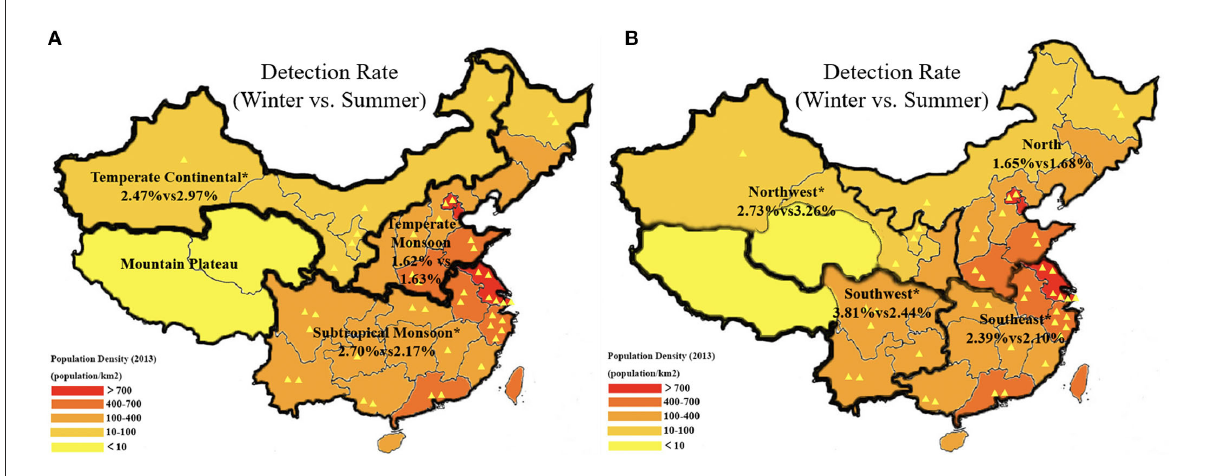
FIGURE2 The detection rates of AKI during winter and summer in different geographical and climatic regions. (A) The detection rate (winter vs. summer) of all-type AKI in 3 climatic regions, namely, temperate continental, temperate monsoon, and subtropical monsoon; (B) The detection rate (winter vs. summer) of all-type AKI in 4 geographical regions, namely, North, Northwest, Southeast, and Southwest. The population density is marked with different colors. Each yellow triangle represents a study hospital. * p <